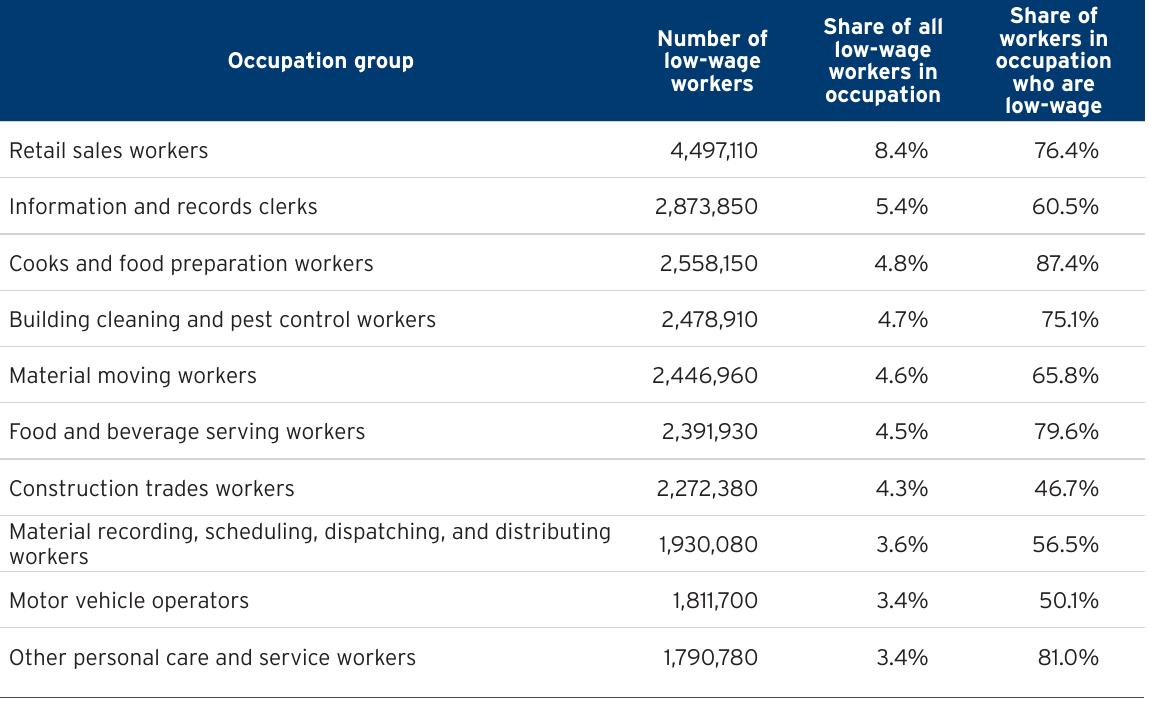
Source: Brookings analysis of 2012-2016 American Community Survey 5-year Public Use Microdata